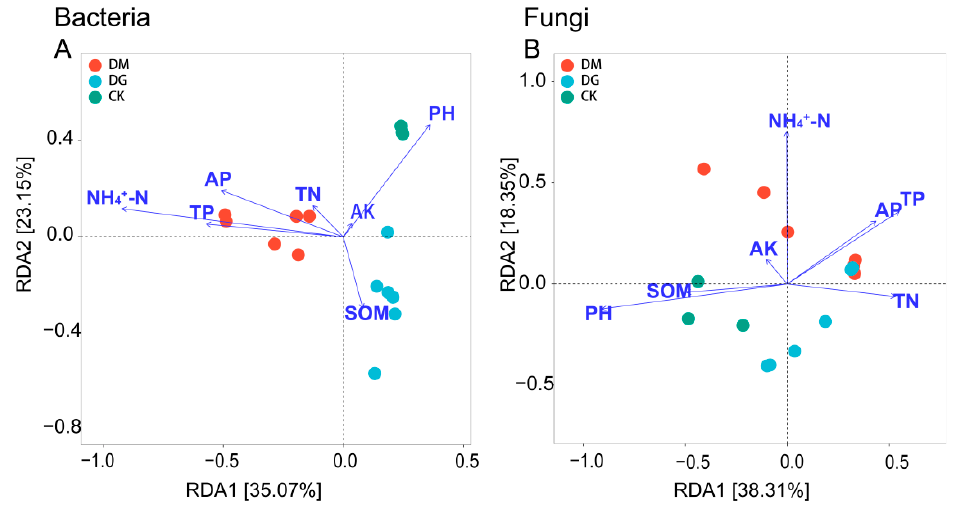
Figure 7. Redundancy analysis of differential bacterial ( A ) and fungal ( B ) and physicochemical factors for different plant continuous-cropping soil types.